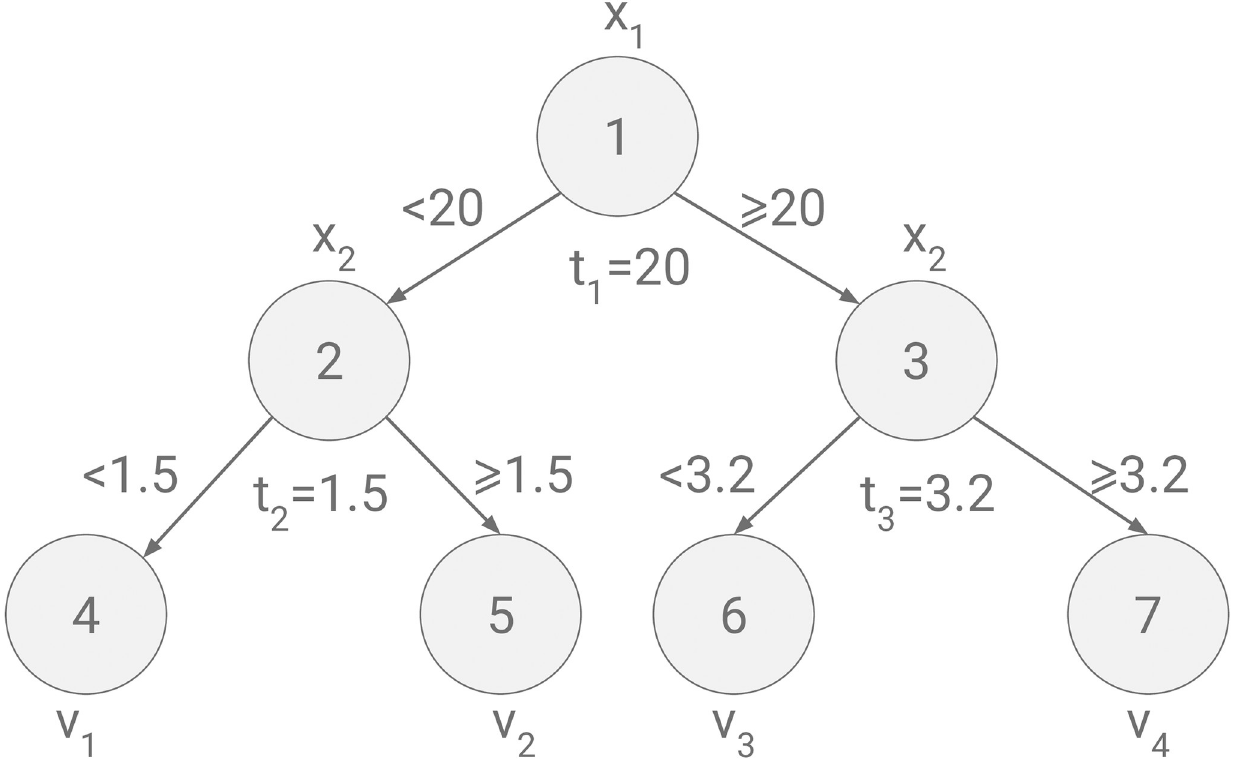
Fig 1. A regression tree including two features X 1 and X 2